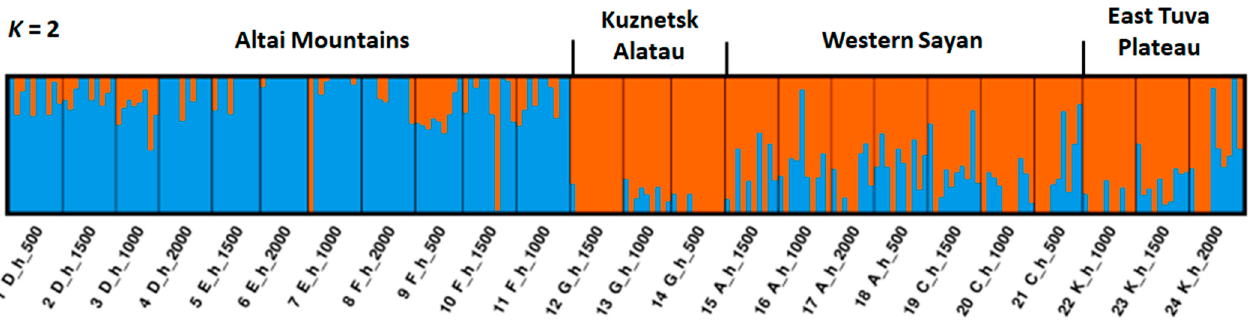
Figure 8. Admixture of the two clusters ( K = 2) indicated by two different colors (Q-values) in indi- vidual Siberian larch trees, representing 24 samples collected at different altitudes in four geographic regions and based on 761 neutral SNPs.